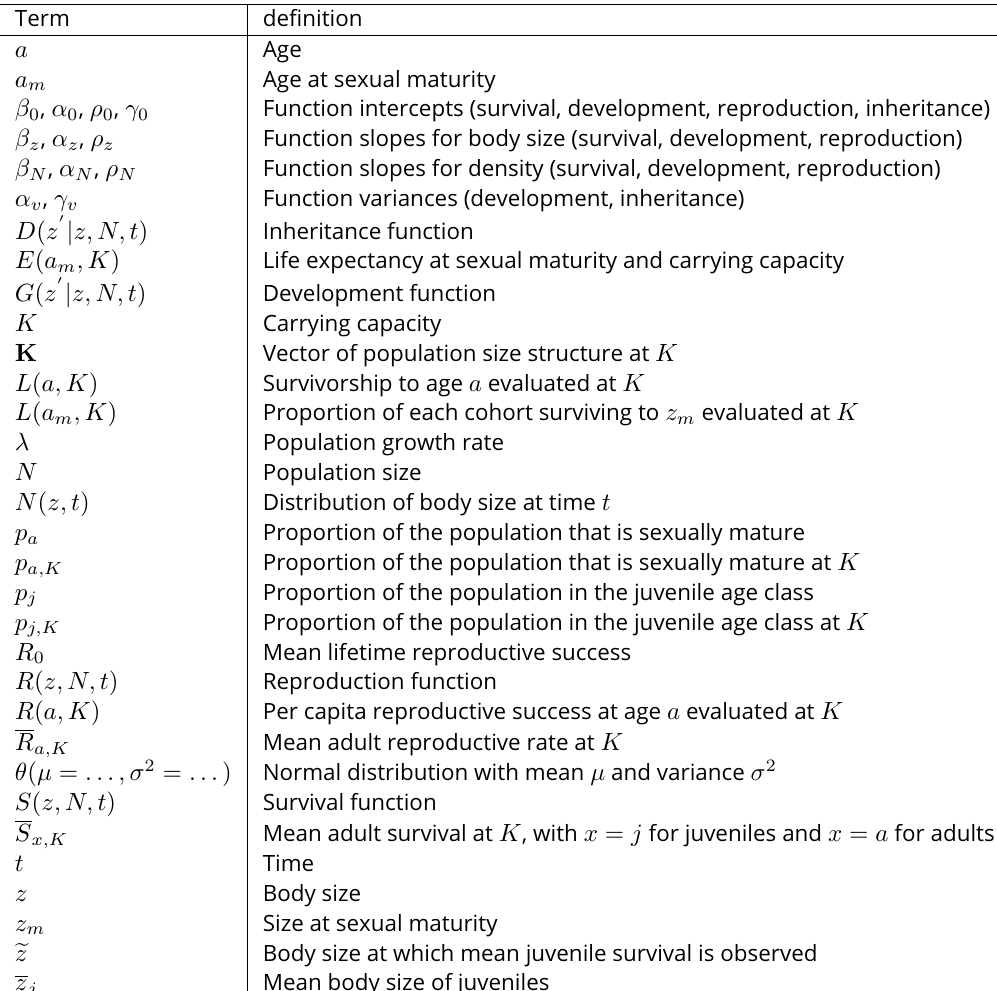
Table 1. Notation used in the paper. Please see Table 2 for values of model parameters.